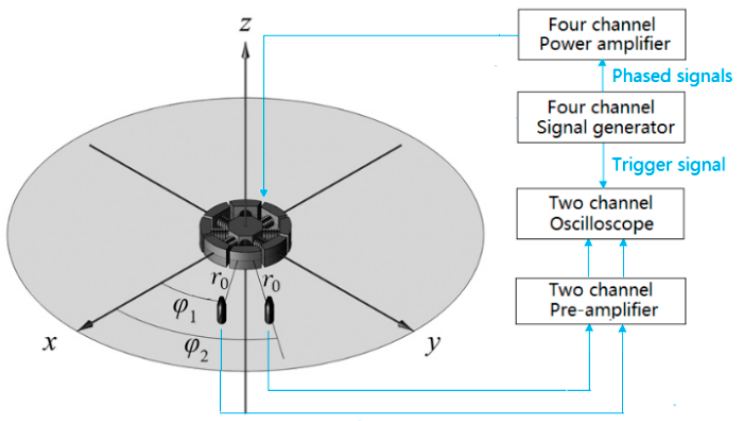
Figure 12. Test transducer placement and equipment connection.